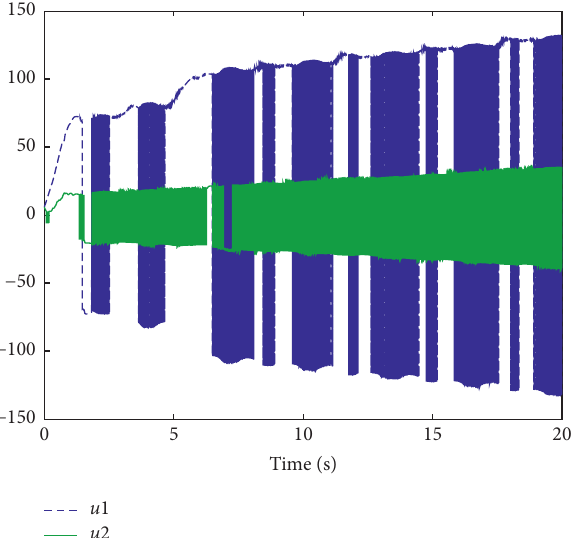
Figure 3: Control input signal for u